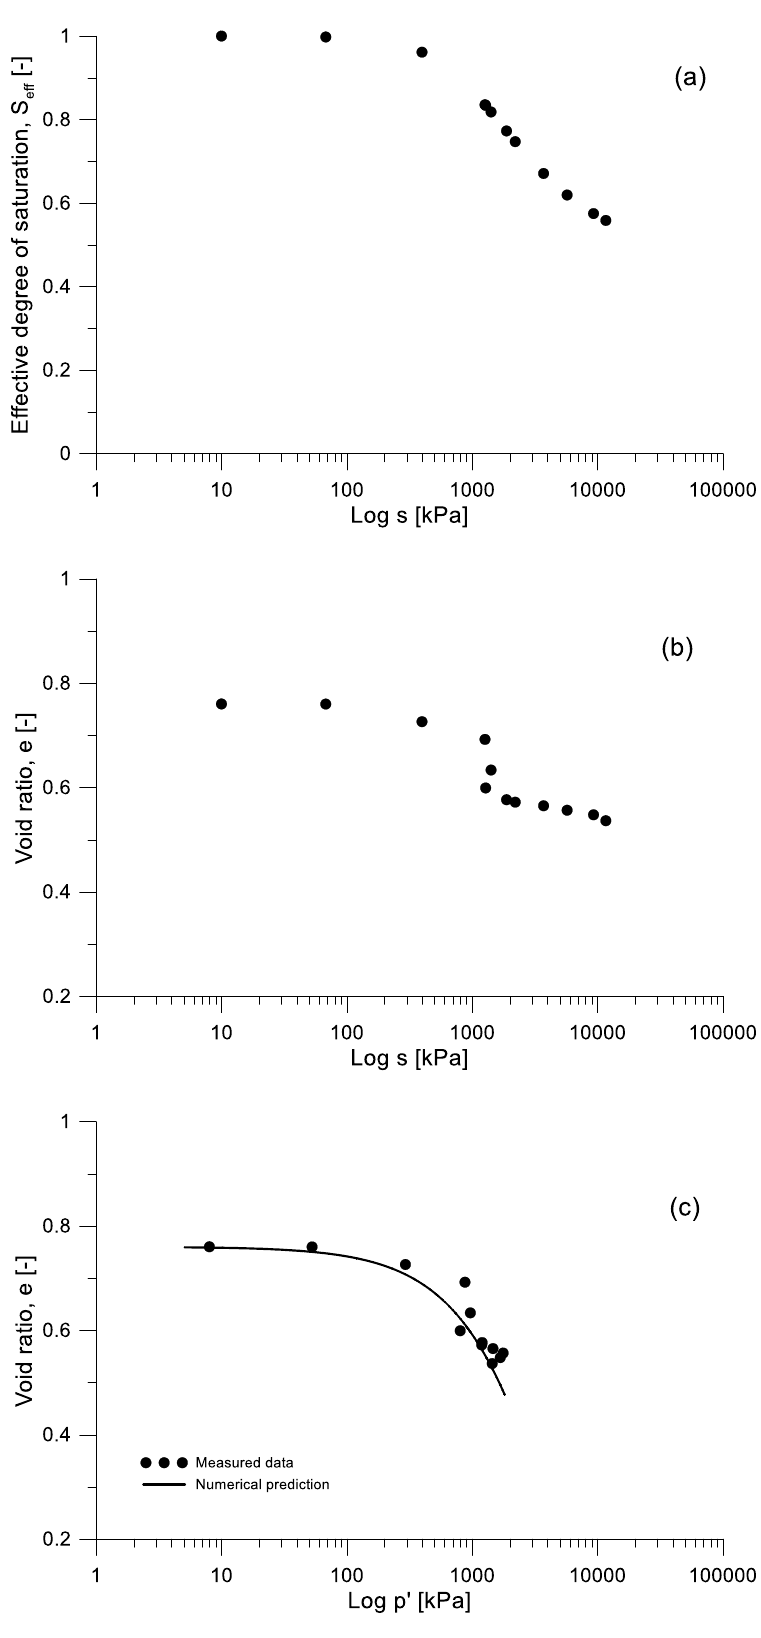
Figure 6. Specimen CO1_1.3m from Pisciolo (data from [3] and [53]); ( a ) and ( b ): measured data in the free drying test; ( c ): observed e–p’ drying path (p’ computed through Equation (3) and S res = 0.45) and its numerical prediction.